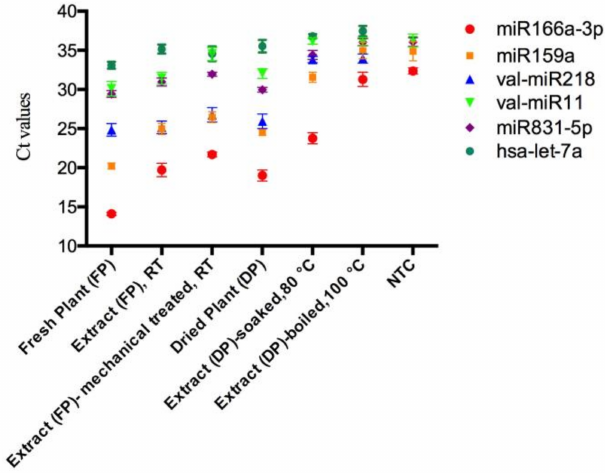
Figure 2. The raw Ct values of miRNAs in mistletoe plants and lyophilized mistletoe extracts detected by qRT-PCR. The Ct values of val-miR218 and hsa-let-7a in the NTCs were undetectable (Ct > 39). Sampling and analysis were carried out three independent times. The data regarding mistletoe extracts were extrapolated from dry weight. NTC represents no-template controls. RT represents room